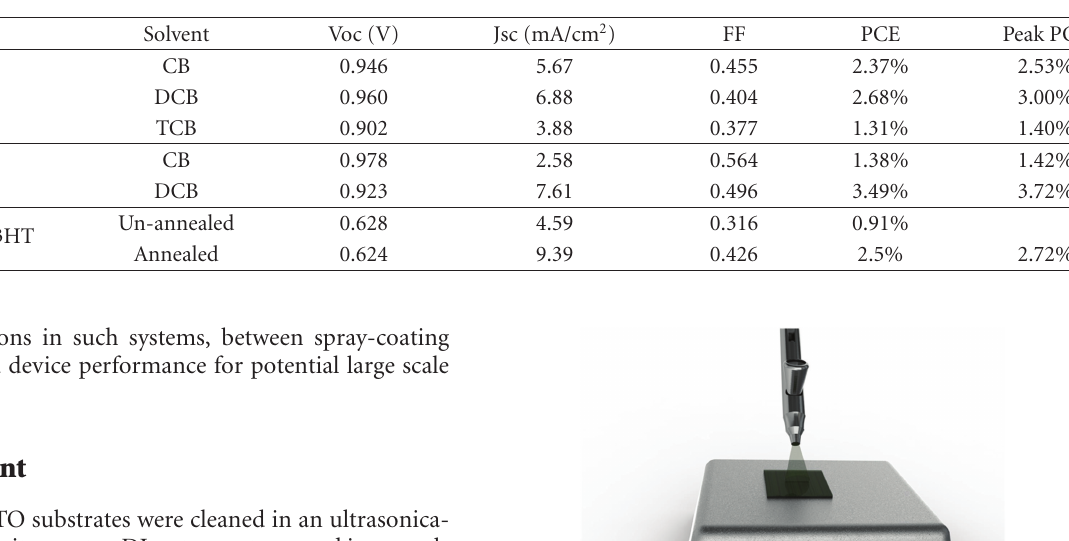
Table 1: Average JV characteristics by spraying coating. P1:PCBM solutions dissolved by CB, DCB and TCB under room temperature and